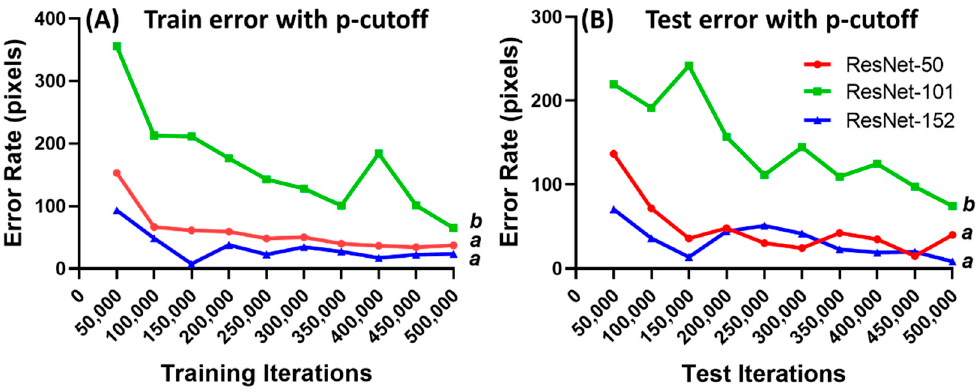
Figure 2. Train error rate ( A ) and test error rate ( B ) with p-cutoff evaluation results with 500,000 iterations in zebrafish heart chambers. The statistical difference was analyzed using ordinary one-way ANOVA, followed by Dunn’s multiple comparison test. The different letters (a and b) indicate significant differences with p < 0.05.